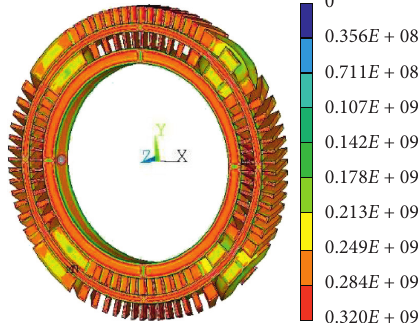
Figure 12: The equivalent stress on the magnet